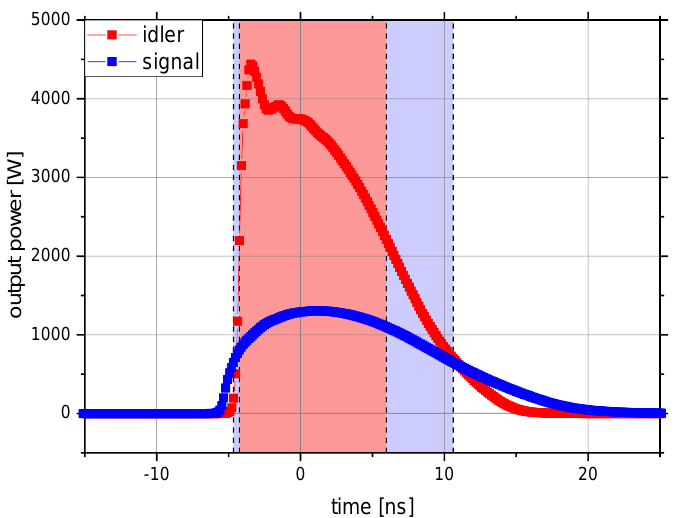
Figure 6. The calculated output pulse shape of the NesCOPO at the signal (blue) and idler (red) wave- length. The shaded areas denote the respective full width at half maximum (FWHM) pulse